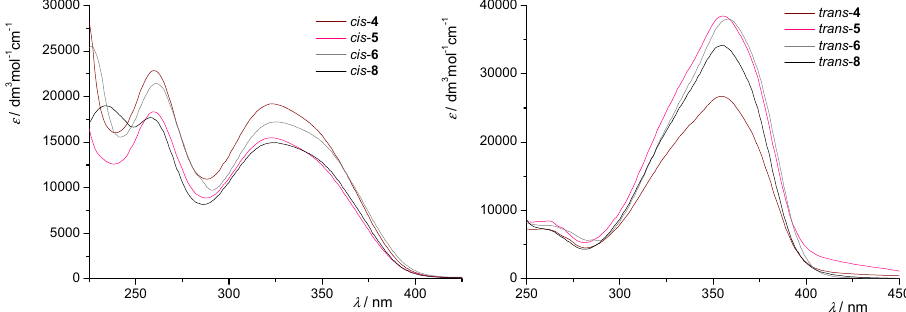
Figure 4. Representative UV-Vis spectra (ACN) of cis - and trans -isomers of newly synthesized styryl-amines 4 – 6 and 8 .